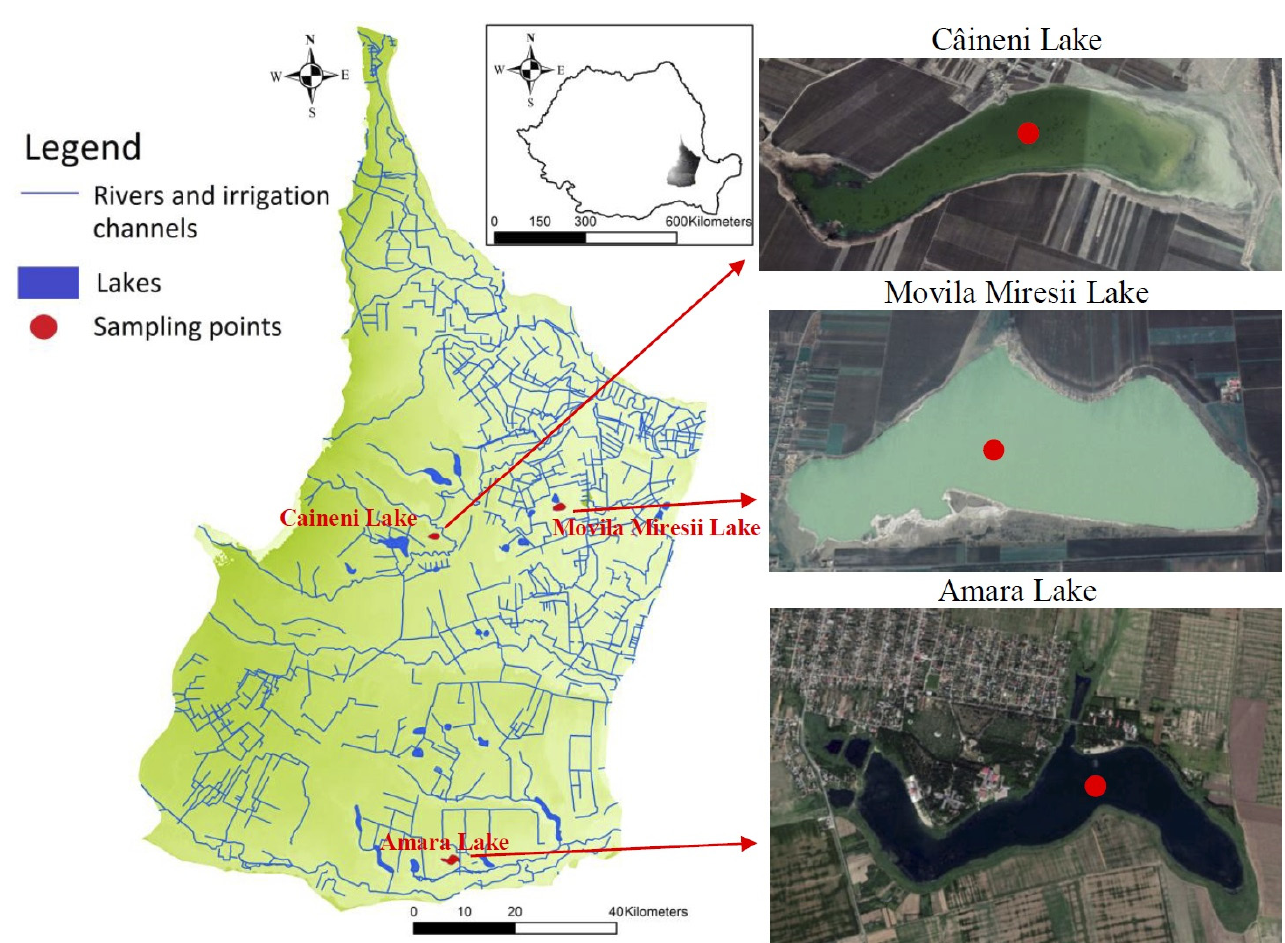
Figure 1. The location of three salt lakes from Romanian Plain and the position related to the sediment cores sampling (data source: left maps—Topographic Map of Romania 1:25,000 actualized and completed; right maps—Google Earth).